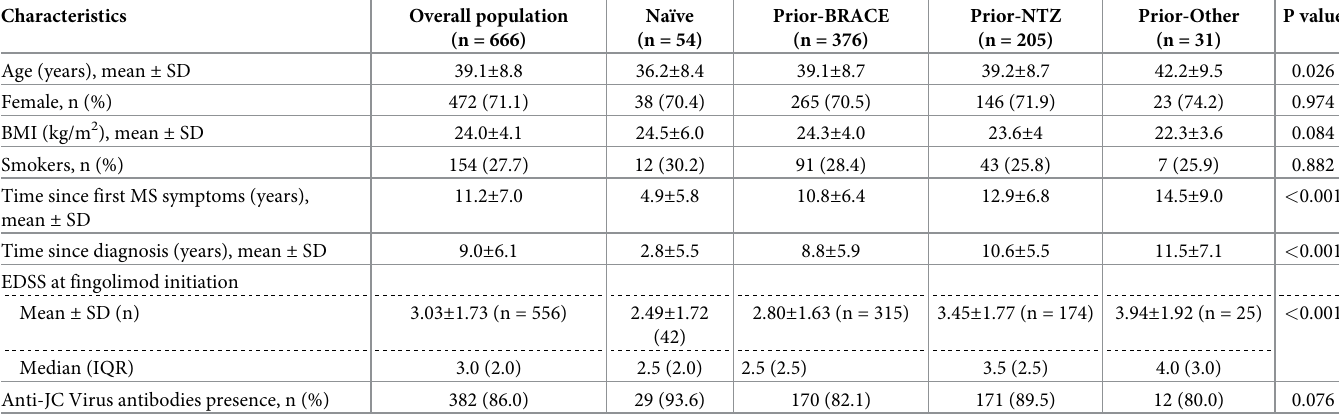
Table 1. Demographic and clinical characteristics at baseline of the overall population and prior treatment subgroups.